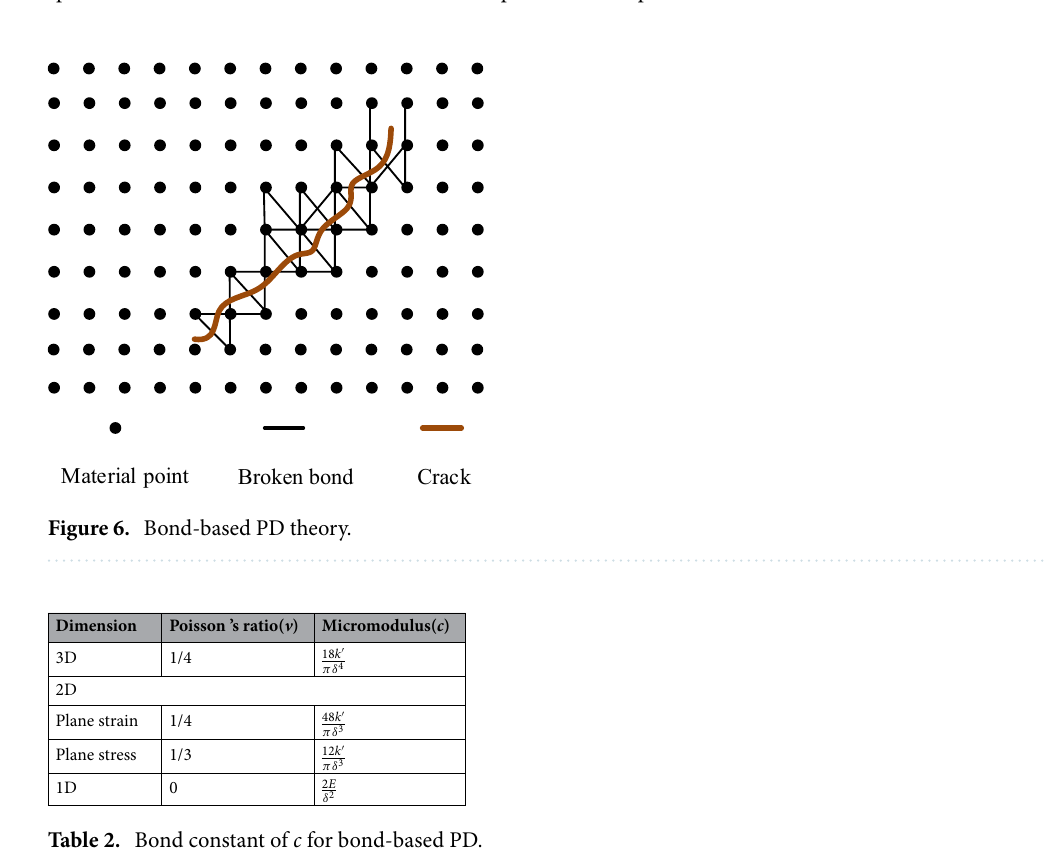
Table 2. Bond constant of c for bond-based